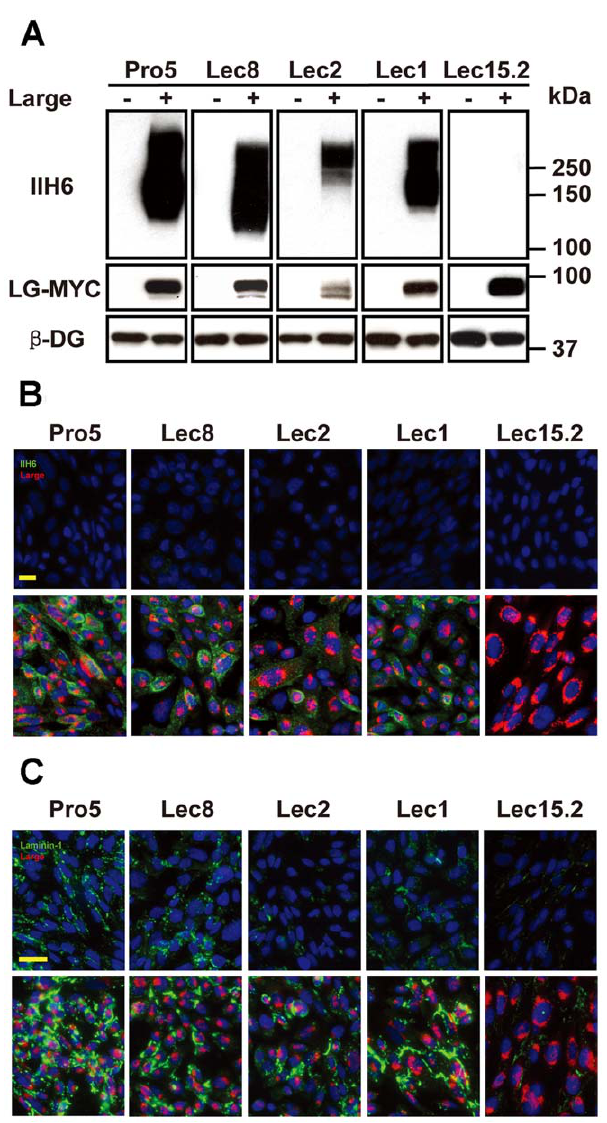
Figure 1. Stable overexpressing Large induces functional glycans in CHO cells. (A) Equal amount of lysates (60 m g proteins each lane) extracted from the cells stably expressing Large as indicated. The immuno-blotting procedure was described in methods section. The glycan antibody IIH6 and anti-MYC antibody (9E10) were used to detect the functional glycans and Large–MYC, respectively. In addition, an anti- b -DG (MANDAG2) antibody was used for detecting dystroglycan as the loading control. (B) The cells as indicated were seeded in 96-well plates and immuno-fluorescent staining was performed as described in the methods section. The images in top panel present the negative controls, while the images of bottom panel present the Large positive cells. A rabbit polyclonal anti-MYC antibody and the IIH6 antibody were used to stain the Large-MYC and glycosylated a -DG, respectively. The cells were also stained with DAPI to visualize the nucleus. The bar is 50 m m. (C) The cells as indicated were seeded in 96-well plate for 24 hour growth. The protocol of laminin clustering assay is described in the methods section. The laminins-DyLight488 was added to the cell culture for 6 hours incubation. A rabbit polyclonal anti-MYC antibody was used to stain Large-MYC protein followed by staining with secondary anti-rabbit antibodies conjugated with Alex594. In addition, DAPI was added to each well to stain the DNA for cells counting. The images were captured with a fluorescent microscope as described in methods section. The bar is 50 m m.